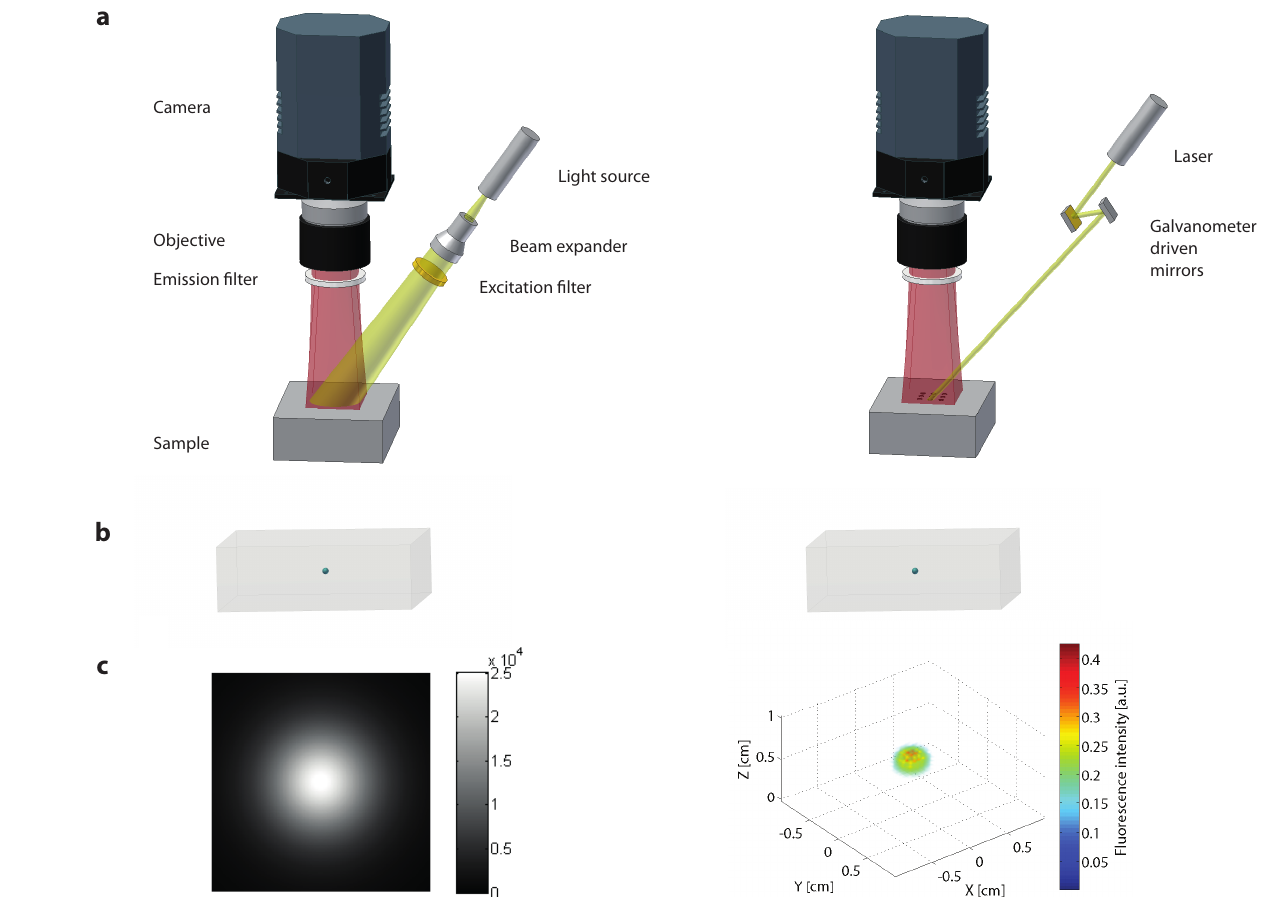
Figure 3. Planar and FMT imaging: ( a ), Setup. Schematic of a planar (left) and an FMT (right) measurement setup and its components in reflection geometry. Transmission geometry (not shown) can be easily achieved by installing either the camera or the source on the other side of the sample. ( b ), Schematic of an embedded fluorophore (turquoise) in depth of a cubic sample (gray). ( c ), (left) Imaging result of the planar setup showing the light distribution at the surface of the sample. Only qualitative information is obtained. (right) Reconstructed fluorophore of an FMT data set allowing the depth resolution and therefore